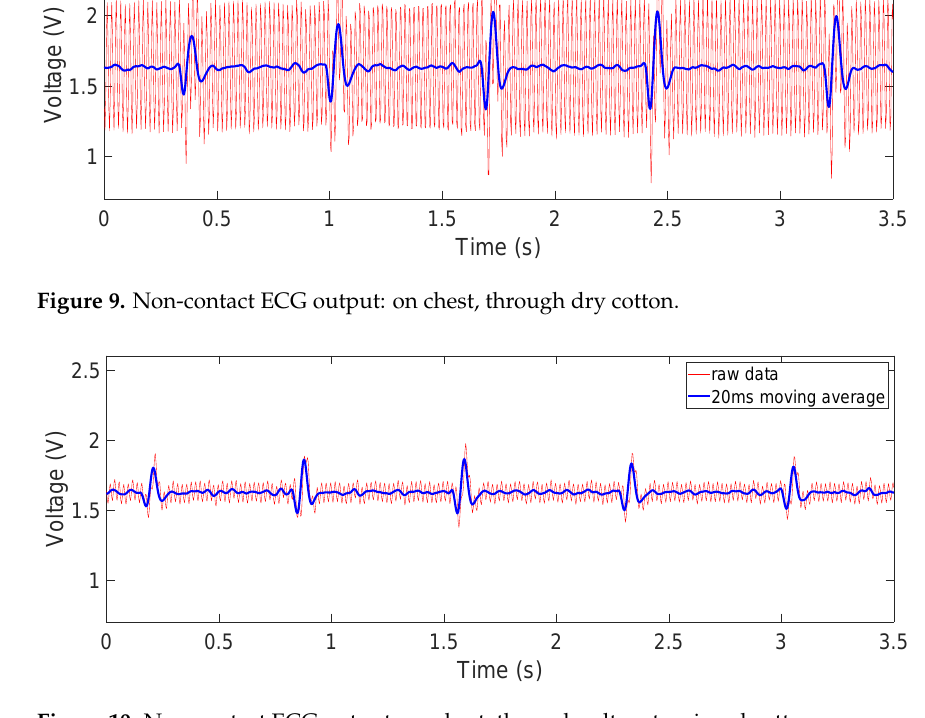
Figure 10. Non-contact ECG output: on chest, through salt water rinsed